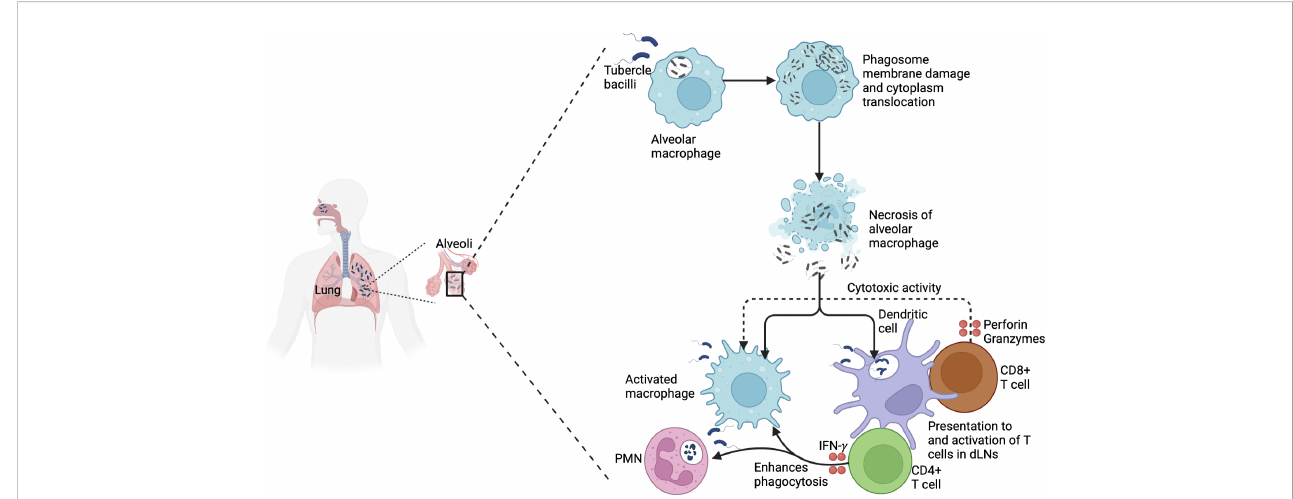
FIGURE 2 TB pathogenesis. Virulent Mtb that is phagocytosed by alveolar macrophages causes phagosome membrane damage and translocates to the cytoplasm. This results in necrosis and spread to other macrophages and dendritic cells. Mtb is processed and presented to CD4 + T cells that produce IFN- g , enhancing the phagocytosis of infected macrophages and polymorphonuclear cells. In addition, activated CD8 + T cells produce perforin and granzymes that mediate the cytotoxic activity of infected